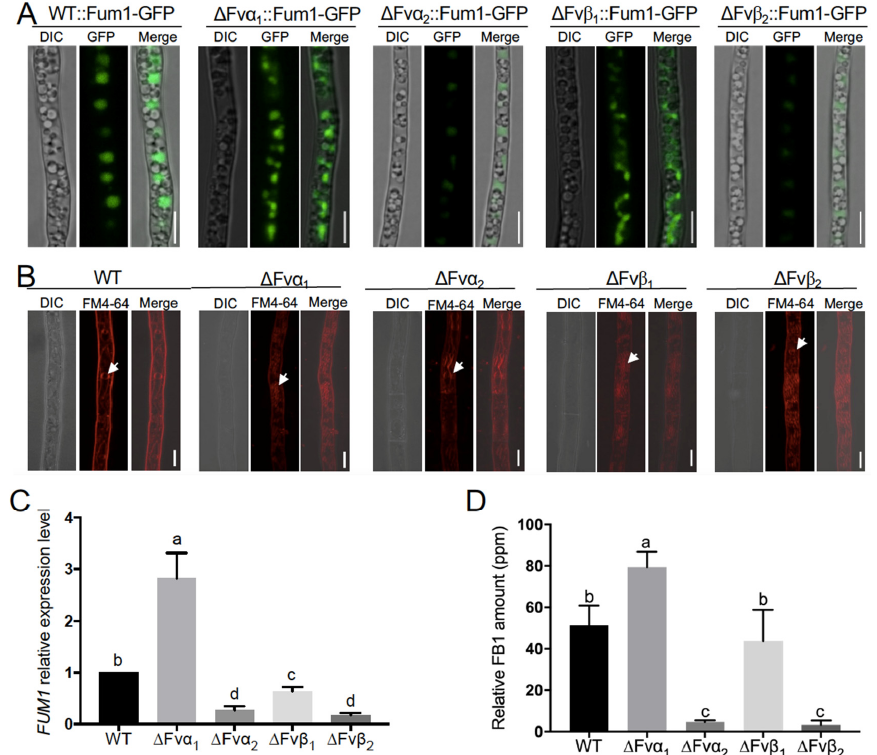
Figure 6. Fv α 1 is negatively associated with FvFUM1 expression and FB 1 biosynthesis. ( A ) Fum1-GFP localization in WT, ∆ Fv α 1 , ∆ Fv α 2 , ∆ Fv β 1 , and ∆ Fv β 2 strains. Scale bar = 5 µ m. ( B ) FM4-64 was used to stain WT, ∆ Fv α 1 , ∆ Fv α 2 , ∆ Fv β 1 , and ∆ Fv β 2 for vacuoles. Bar = 5 µ m. ( C ) RT-qPCR results for FvFUM1 under treatment of 1 µ g/mL carbendazim relative to levels in myro broth. Significant differences were indicated with different letters on the bars according to prism two-way ANOVA at p < 0.05. ( D ) WT, ∆ Fv α 1 , ∆ Fv α 2 , ∆ Fv β 1 , and ∆ Fv β 2 were cultivated on autoclaved corn kernels for 8 days at room temperature. FB 1 levels were normalized with fungal ergosterol levels. Different letters on the bars indicated significance according to prism Ordinary one-way ANOVA multiple comparisons at p <